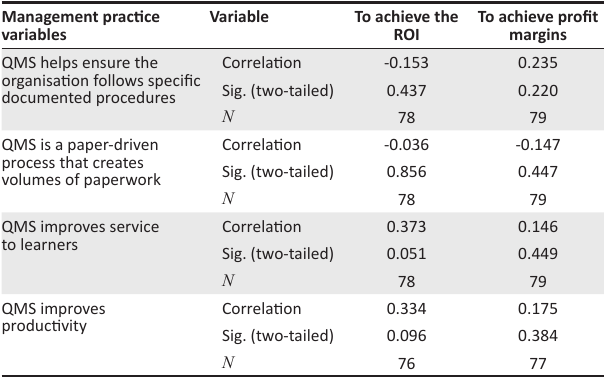
TABLE 3: Effect of management practices on both the return on investment and profit